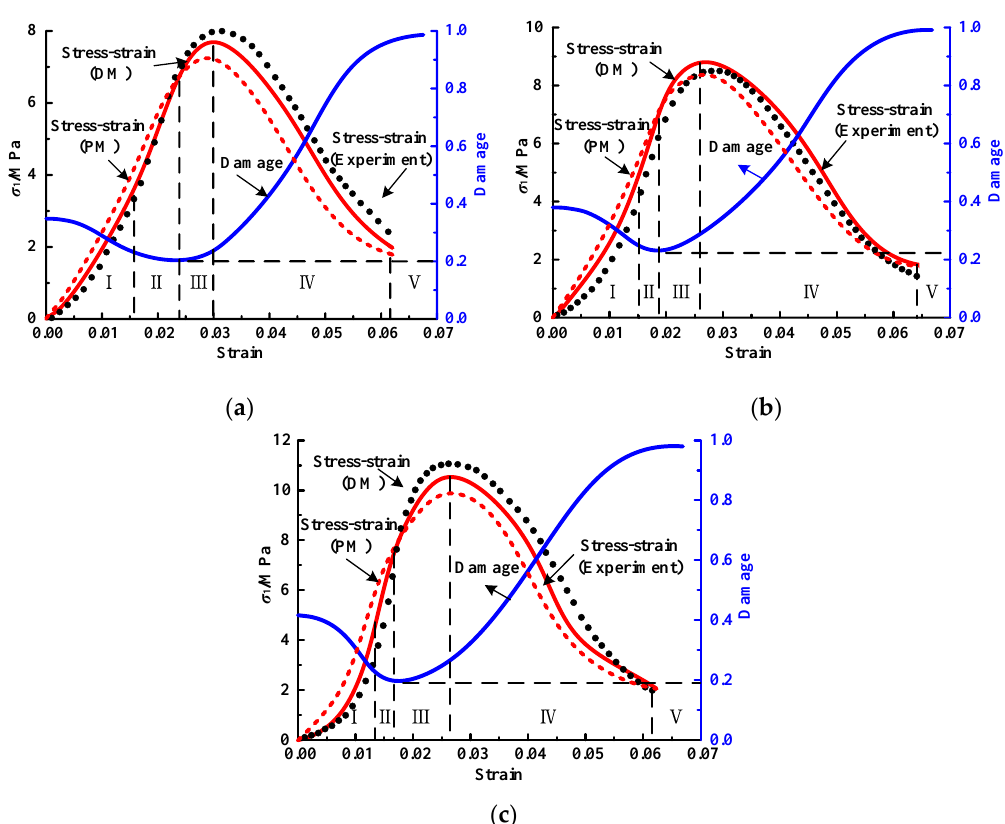
Figure 9. Comparison between experimental and theoretical curves of cement mortar: ( a ) A-0.1 – 2; ( b ) A-0.5 – 3; ( c ) A-1.0 – 2.